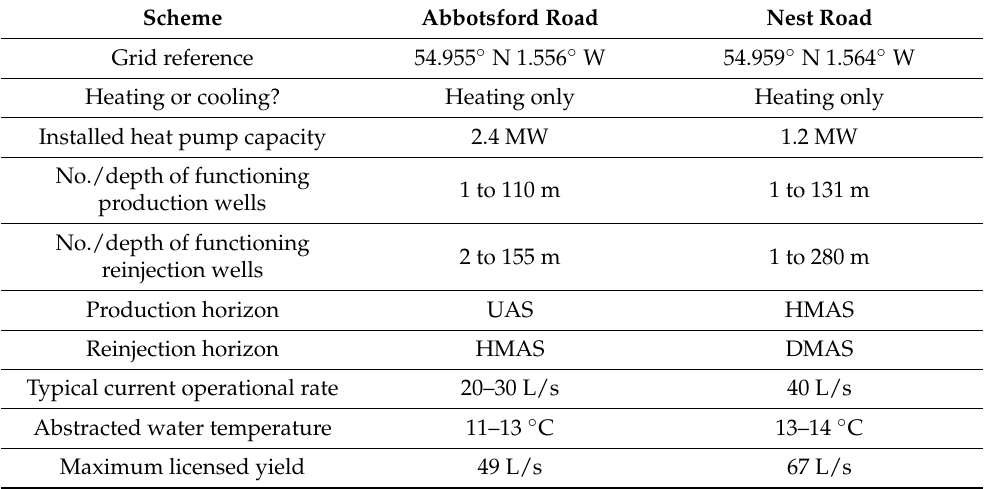
Table 1. Summary of the Abbotsford Road and Nest Road mine water geothermal energy schemes. UAS = Upper Aquifer System, HMAS = High Main Aquifer System; DMAS = Deep Mined Aquifer